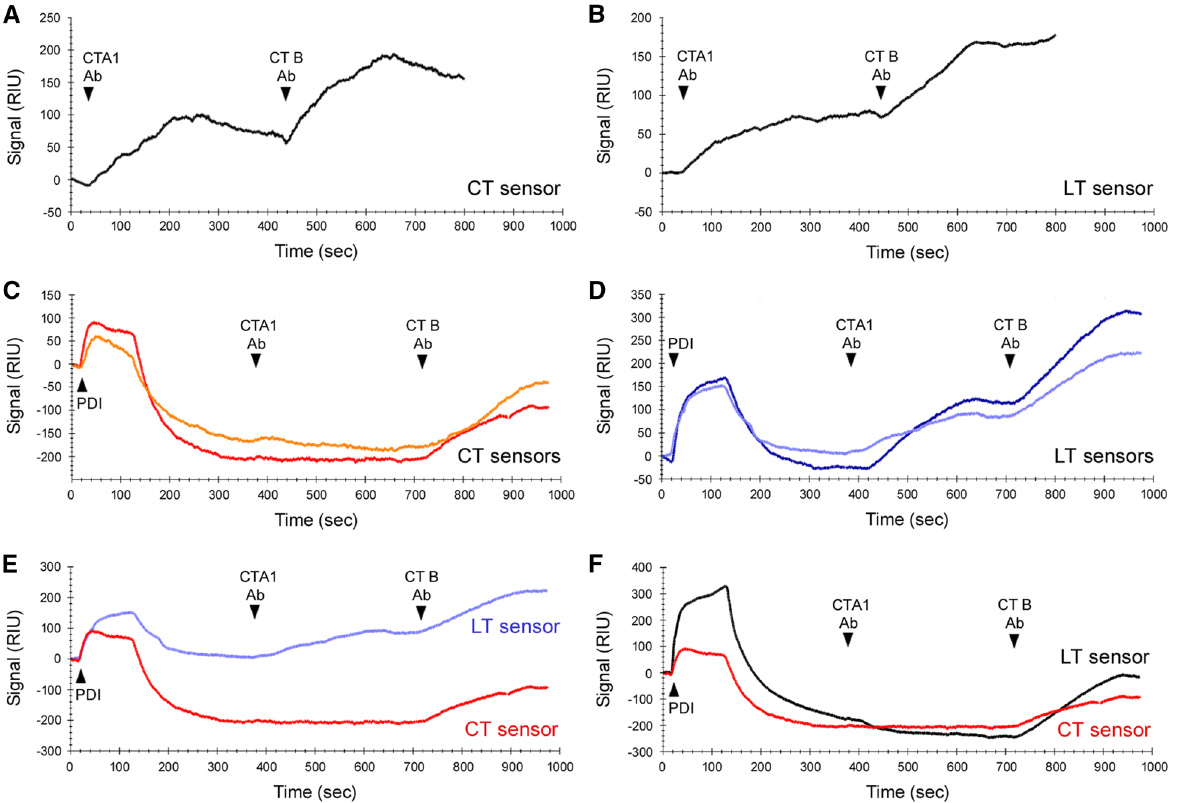
Figure 5. Relative kinetics of CT/LT disassembly by PDI. CT or LT was appended to a GM1-coated SPR sensor, and a baseline measurement corresponding to the mass of the sensor-bound holotoxin was taken to establish the 0 RIU signal. ( A-B ) Antibodies against the CTA1 and CTB subunits were perfused over a CT-coated ( A ) or LT-coated ( B ) sensor as indicated. ( C,D ) Buffer containing 1 μM PDI and 1 mM DTT was added to a CT-coated ( C ) or LT-coated ( D ) sensor. This was followed by sequential injections of antibodies against the A1 and B subunits, as indicated. Results from two independent experiments are shown for each toxin. ( E ) Traces for one CT disassembly experiment (red, from C ) and one LT disassembly experiment (light blue, from D ) are overlaid for comparative purposes. ( F ) An LT disassembly experiment performed with 10 μM PDI in the perfusion buffer (black) is overlaid with a CT disassembly trace (red, from C